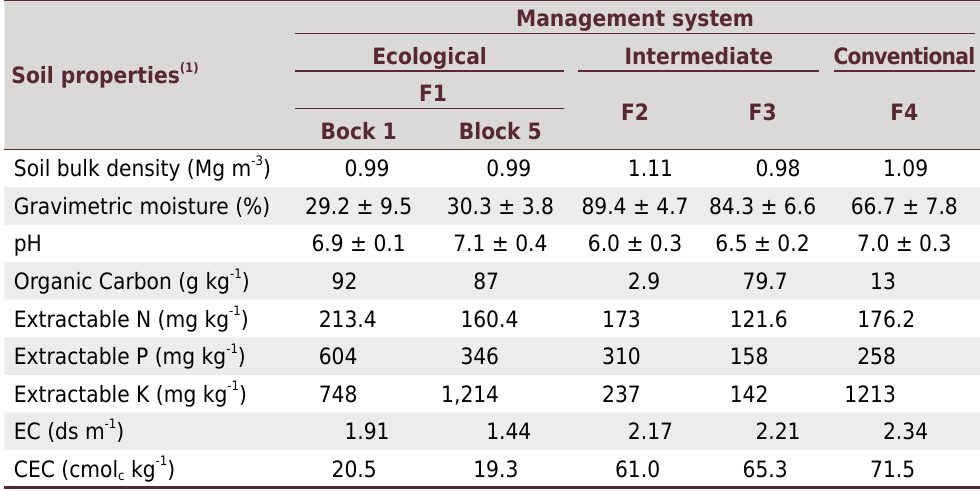
Table 2. Main soil physicochemical properties at the sampling sites